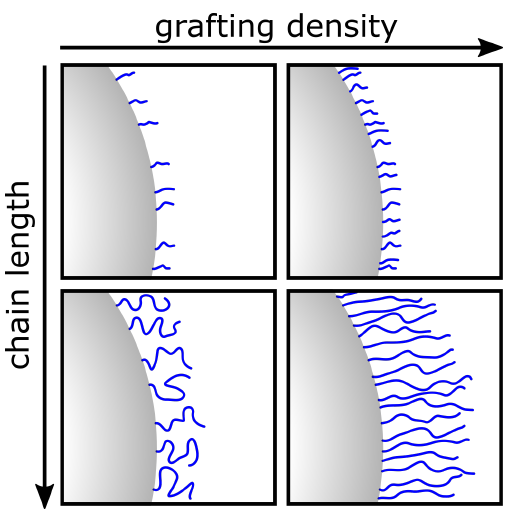
Figure 1. Controlled grafting density and chain length using surface initiated atom transfer radical